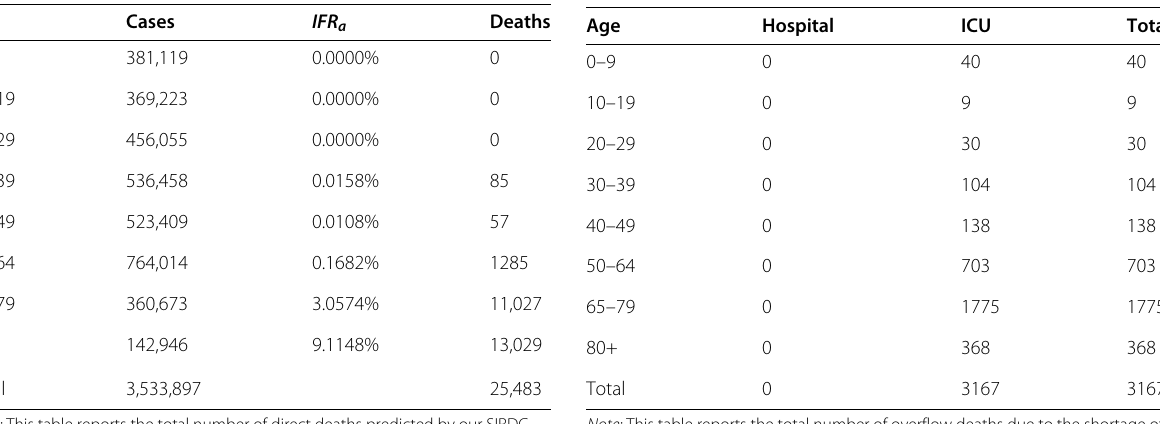
Table 14 Direct deaths—SIRDC model Table 15 Overflow deaths—SIRDC